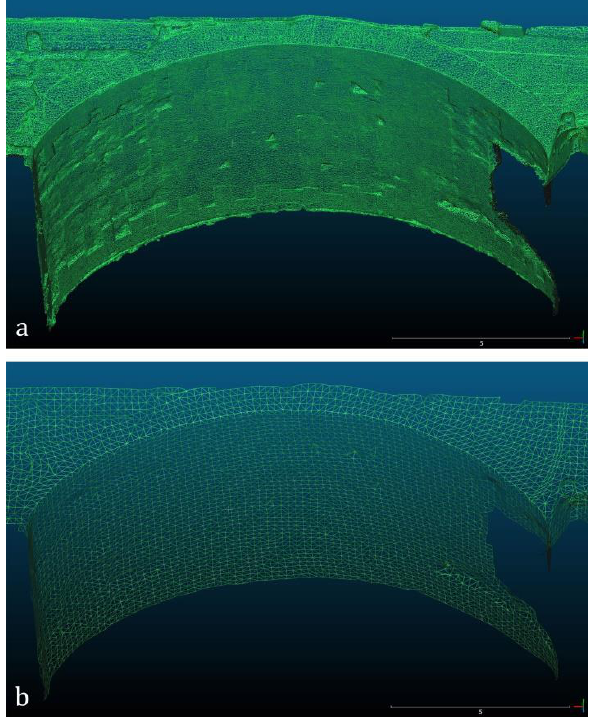
Figure 12. Representation of: a) the complex mesh; b) the simplified mesh after its retopology.